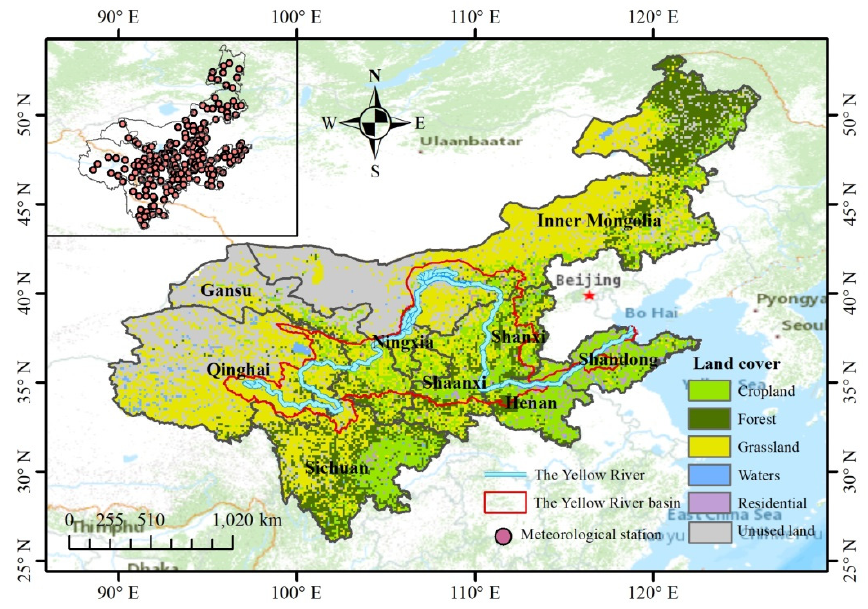
Figure 1. Meteorological stations and land use distribution map in the nine provinces of the Yellow River basin.